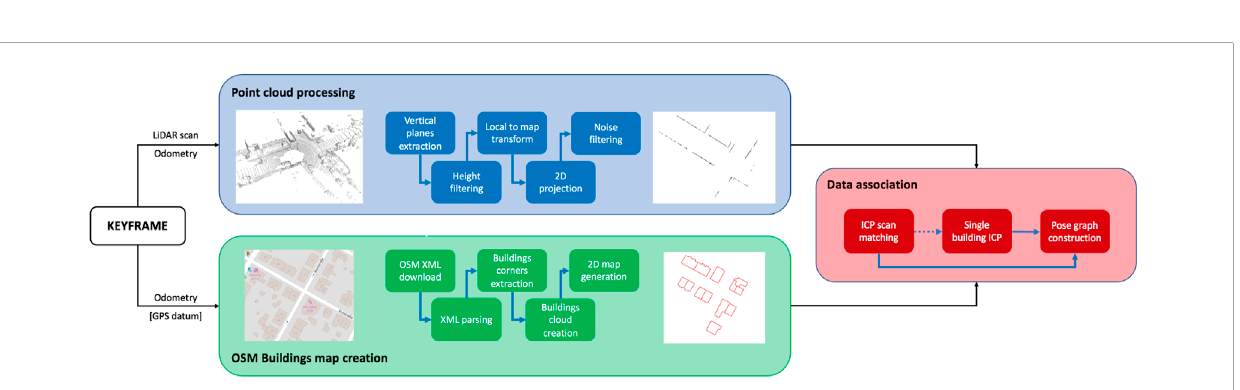
it in the pose graph as height and rotational constraints. As